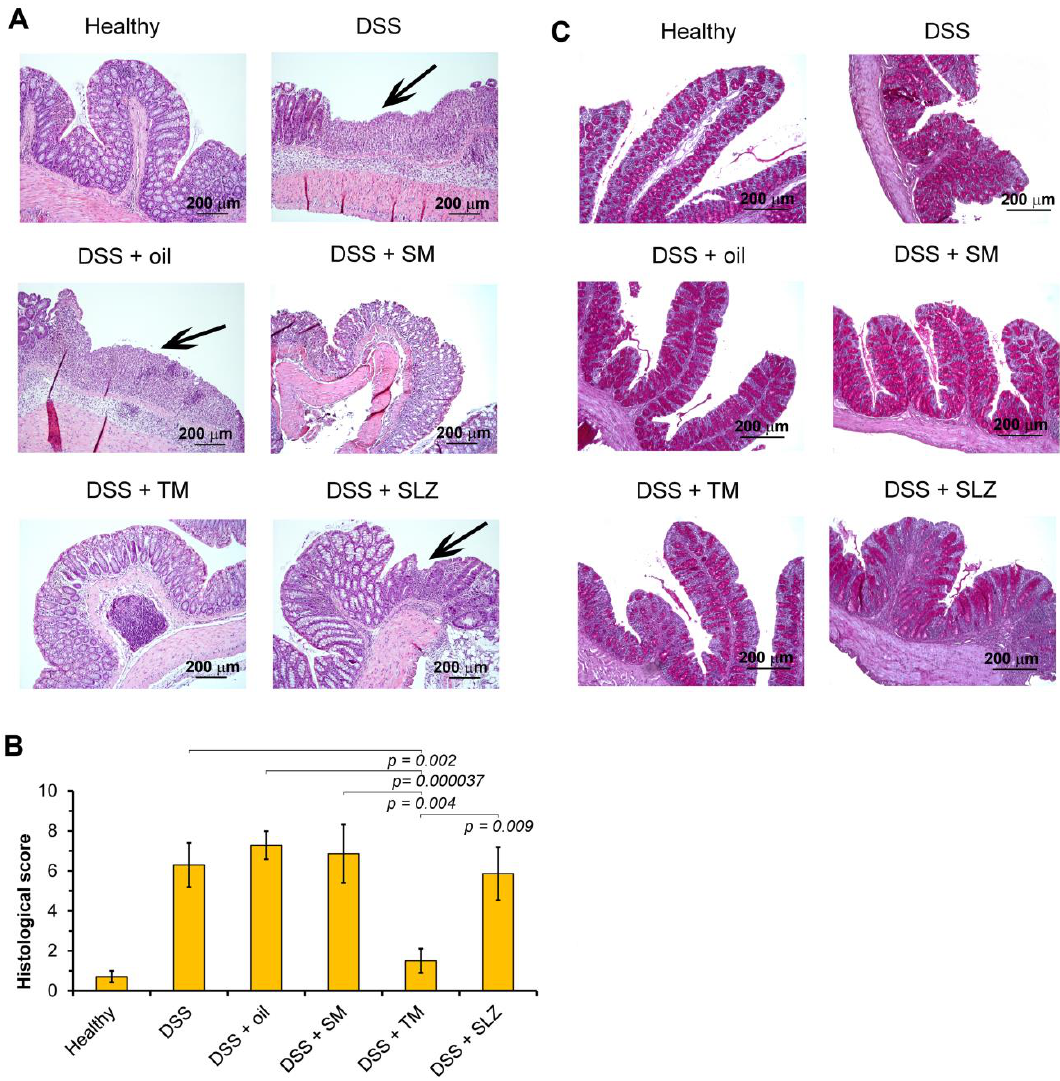
Figure 4. TM inhibited DSS-induced epithelial damage, inflammatory infiltration and mucin hyperproduction in colon tissue and could target thrombin. ( A ) The e ff ect of triterpenoids on the epithelial damage and the inflammatory infiltration in colitis mice. Black arrows indicate the ulcerative foci. Hematoxylin and eosin staining, magnification × 100. ( B ) The e ff ects of SM and TM on the colitis severity were quantified by the histological scoring system. The data are presented as the means ± SD ( n = 7 per group). ( C ) The e ff ect of SM and TM on the mucin production of goblet cells of epithelial crypts in colitis mice. Periodic Acid-Schi ff (PAS) staining, magnification ×